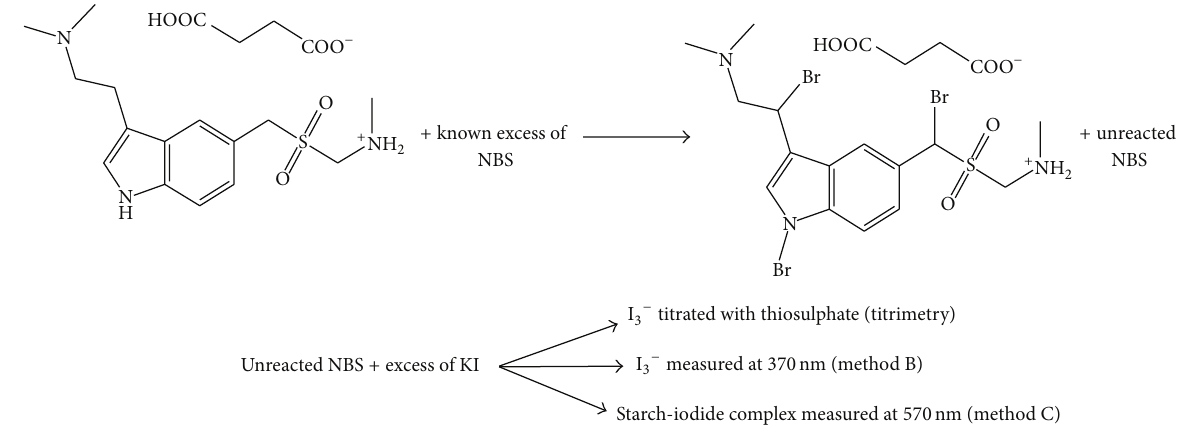
Scheme 1: Proposed reaction pathway for the bromination of STS by